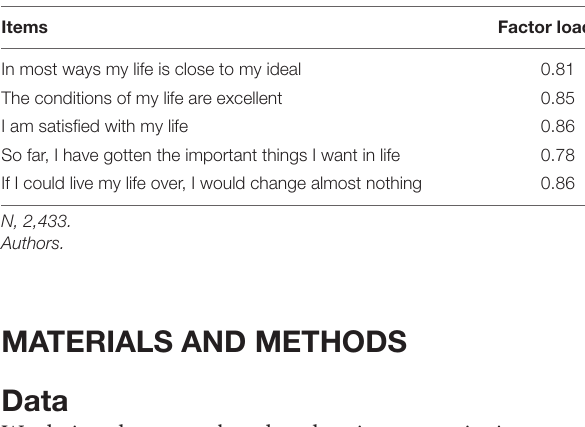
TABLE 4 | Satisfaction with life scale items and factor